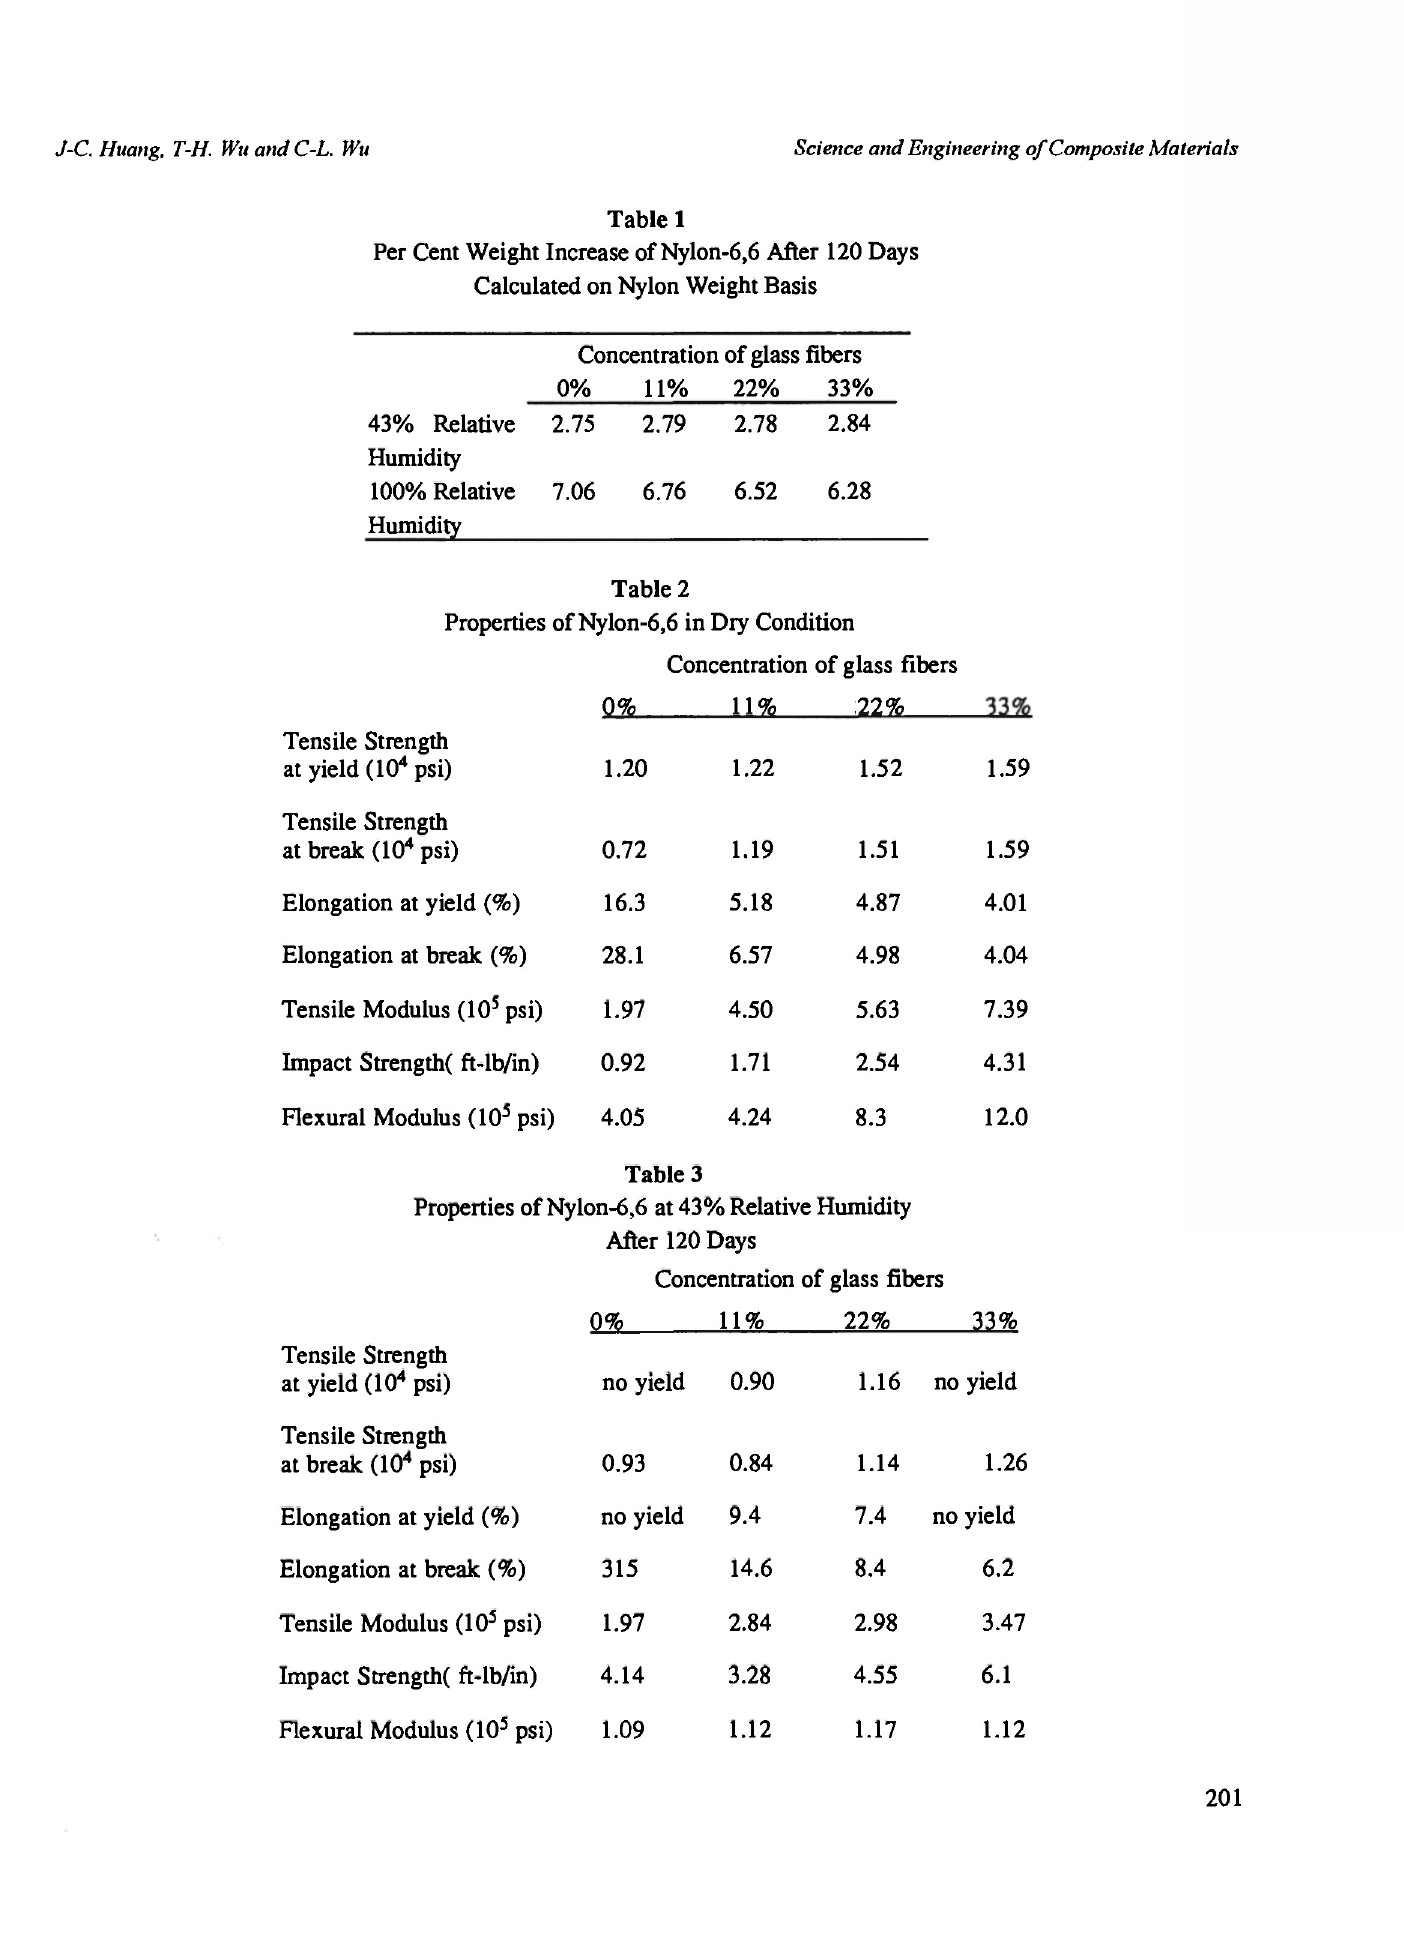
Properties of Nylon-6,6 in Dry Condition Concentration of glass fibers